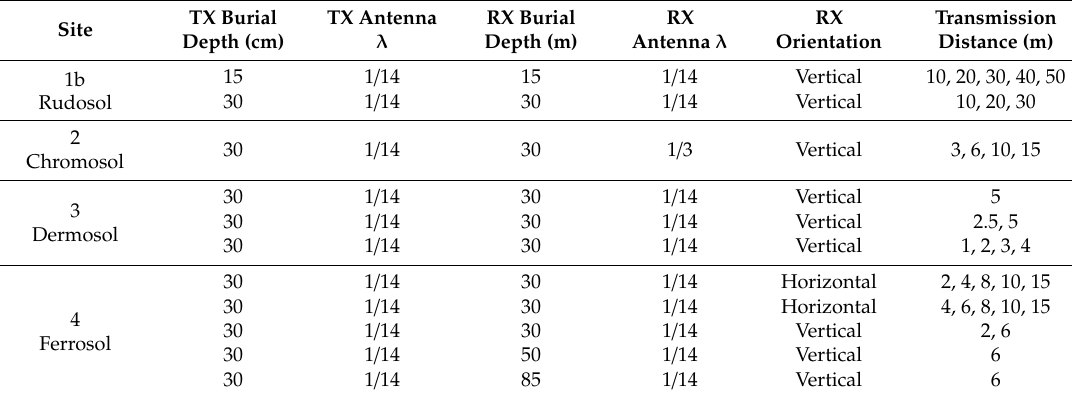
Table 3. Details of underground-to-underground (UG2UG)